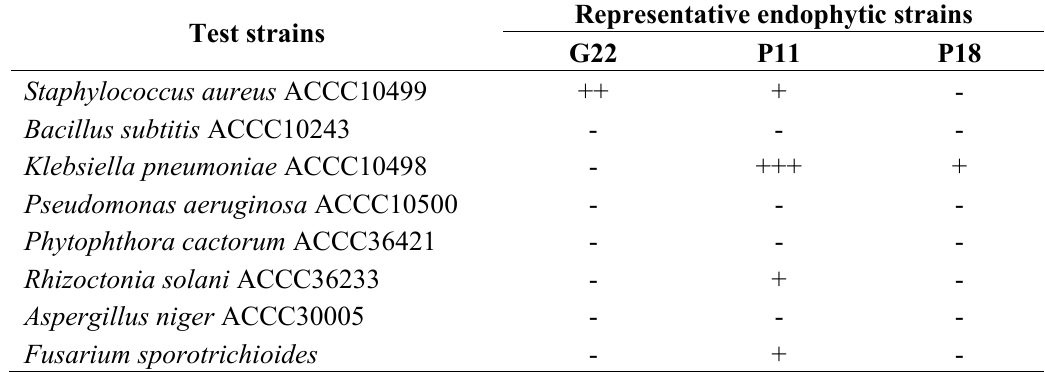
Table 3. Antimicrobial activity of representative endophytic fungi strains. Test